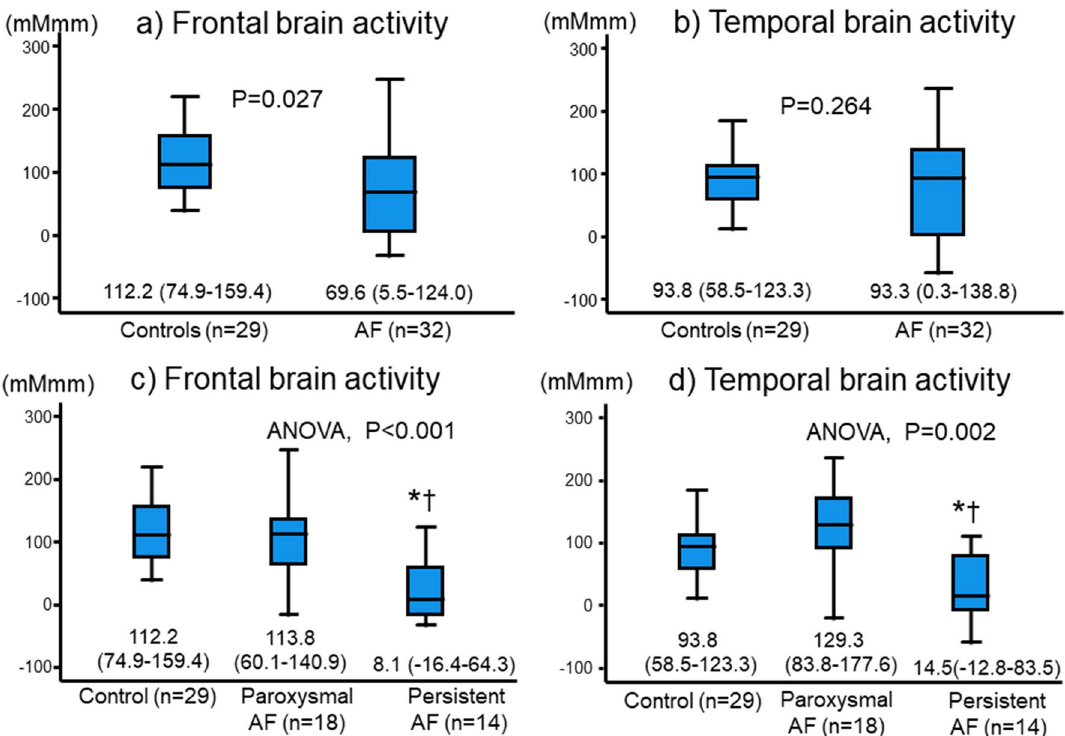
Figure 3. Comparisons of frontal brain activity (integral values of mean oxy-Hb concentrations in the frontal region) and temporal brain activity (integral values of mean oxy-Hb concentrations in the temporal lobes) between the atrial fibrillation (AF) patients and control subjects. Although frontal brain activity was significantly lower in the AF patients than in the control subjects ( a ), temporal brain activity did not differ between the groups ( b ). However, both frontal and temporal brain activities were lower in the persistent AF patients than in the control subjects and paroxysmal AF patients ( c , d ). Data is presented as median and interquartile range (error